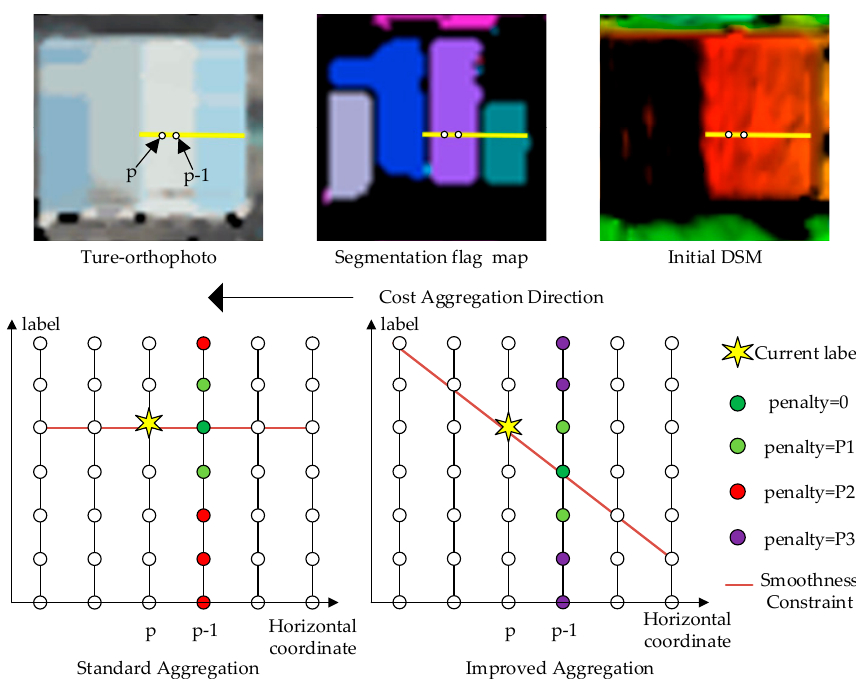
Figure 8. Standard aggregation (Equation (4)) and improved aggregation (Equation (6)). p-1 represents the previous point of p along the current aggregation direction.